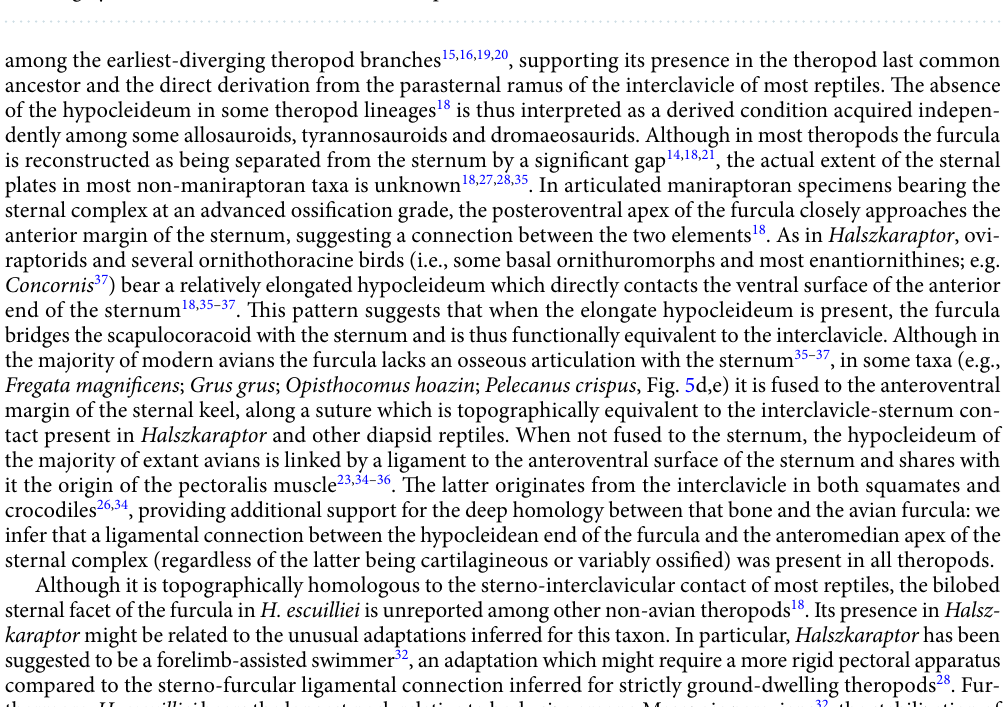
involving the interclavicle and the sternum 18,38 . Nodal optimisation under accelerated transformation. Colored branches indicate clades mentioned in the text. ( b–e ) Evolution of the pectoral apparatus along the avian-stem lineage (ventral view, scapula omitted for clarity). ( b ) Dinosaurian ancestral pattern; ( c ) early theropod pattern; ( d ) pennaraptoran pattern; ( e ) ornithuromorph pattern. cl clavicle, co coracoid, ic interclavicle, st sternum. Drawing by AC, with silhouettes modified from previous studies 1,32,41